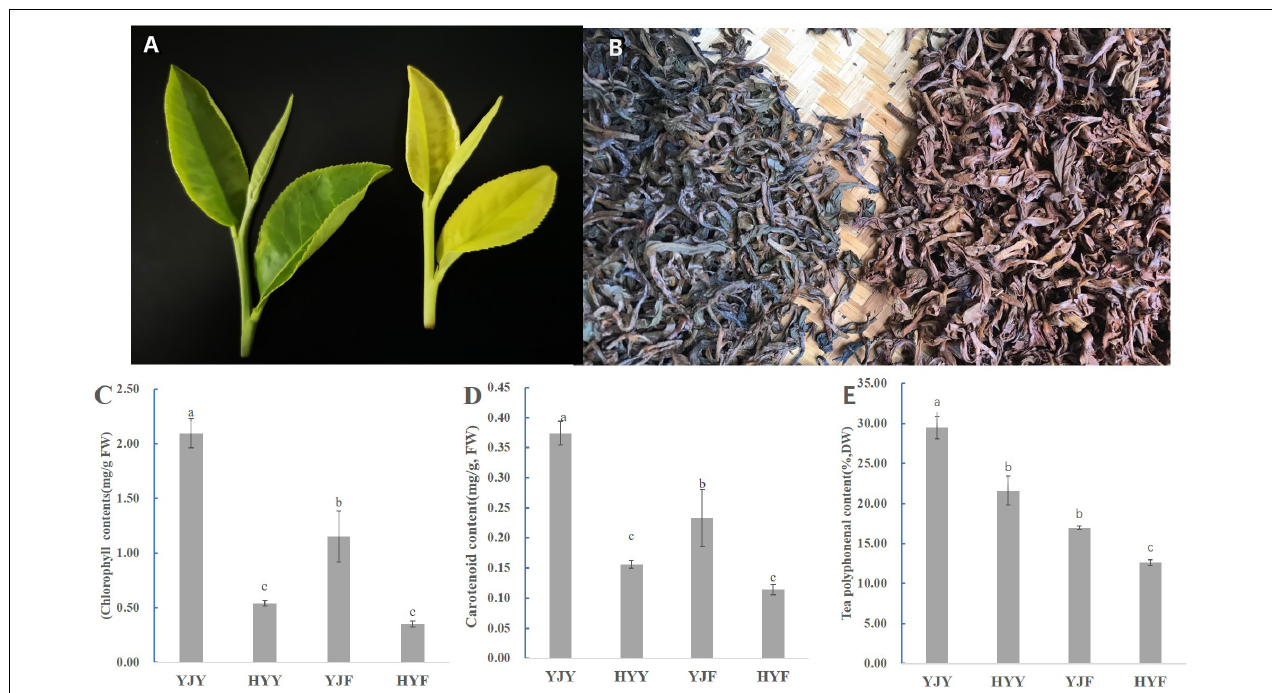
FIGURE 1 | Phenotypes and pigment content in “Yinghong 9” and “Huangyu” leaves. (A) Leaf phenotypes of “Yinghong 9” and “Huangyu.” (B) Appearance of “Yinghong 9” and “Huangyu” fermented leaves. (C) Total chlorophyll content of “Yinghong 9” and “Huangyu” leaves. (D) Carotenoid content of “Yinghong 9” and “Huangyu” leaves. (E) Total tea polyphenols content of “Yinghong 9” and “Huangyu” leaves. The data are presented as the mean standard deviation ( n = 3). Means with different letters at each treatment represent a significant difference at p ≤ 0.05. YJY was “Yinghong 9” fresh leaves, YJF was “Yinghong 9” fermented leaves; HYY was “Huangyu” fresh leaves, HYF was “Huangyu” fermented